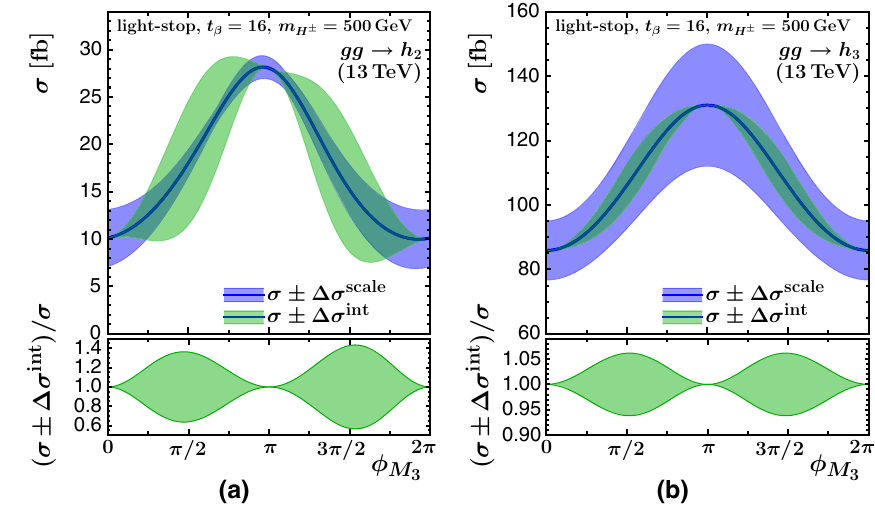
Fig. 11 Renormalisation and factorisation scale uncertainties (cid:8)σ scale ( blue ) and interpolation uncertainties (cid:8)σ int ( green ) for the gluon-fusion cross section of a h 2 and b h 3 as a function of φ M 3 in the light-stop inspired scenario. In the lower panel the upper and lower edge of the band of the cross section prediction with the assigned interpolation uncertainty is normalised to the cross section without this